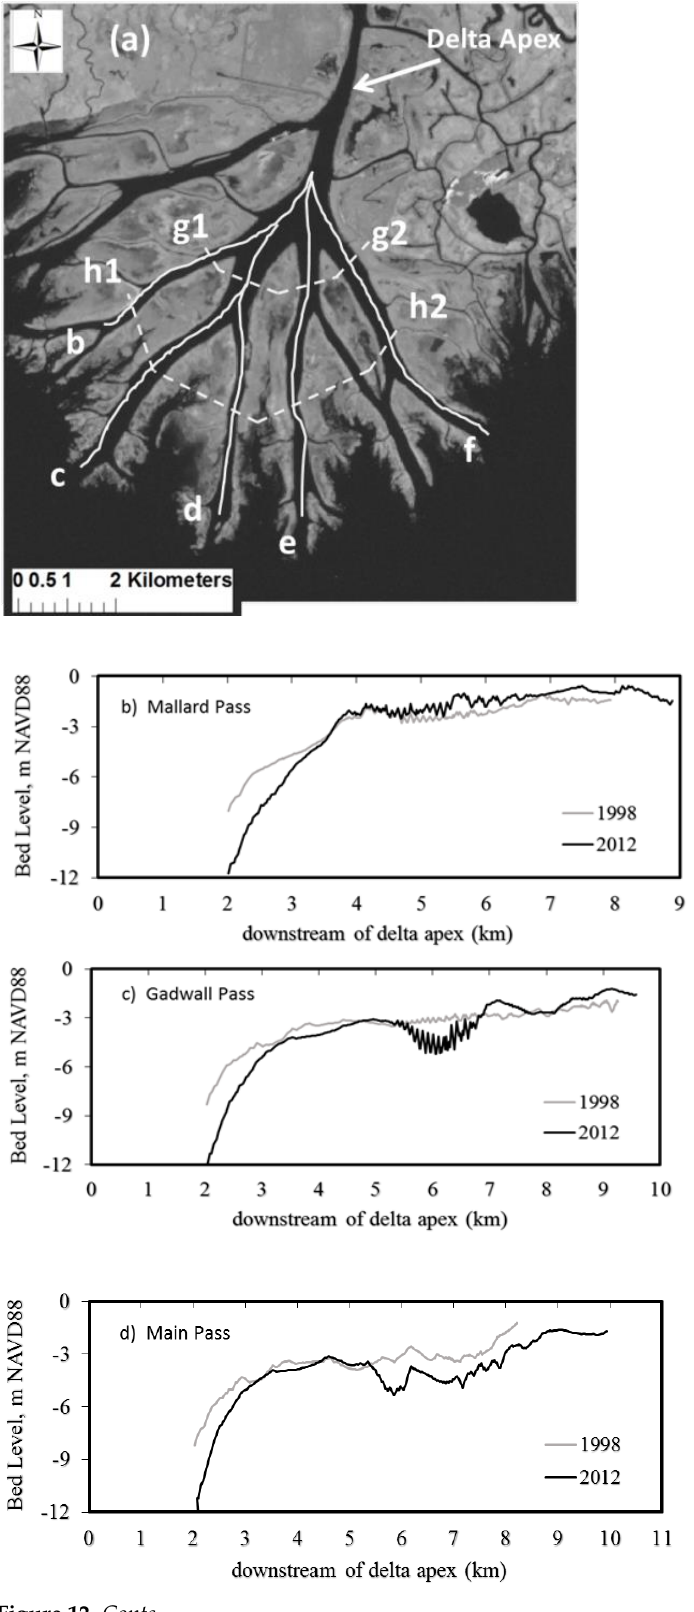
Figure 12. Conts